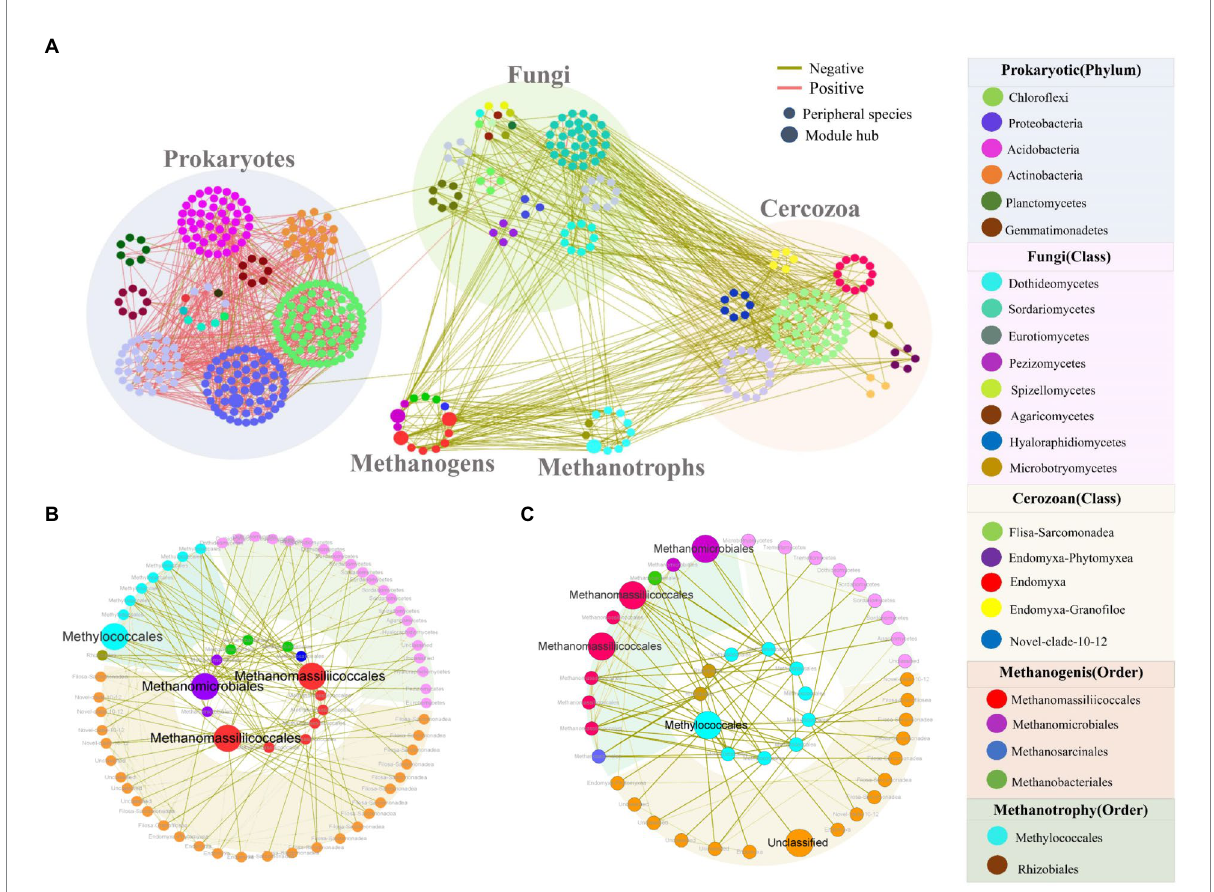
FIGURE 3 Intertrophic networks among five communities and two subnetworks relative to methanotrophic OTUs and methanogenic OTUs. (A) Intertrophic networks of prokaryotic, fungal, cercozoan communities, methanotrophic OTUs and methanogenic OTUs under inundation. Node color indicates different taxonomic. Node size is proportional to network role, with larger nodes being module hubs. Red and green links represent positive and negative interactions, respectively. (B) Subnetworks showing the OTUs related to methanogenic OTUs, inner circle are methanogenic OTUs while outer circles are their connected OTUs. (C) Subnetworks showing the OTUs relative to methanotrophic OTUs, inner circle are methanotrophic OTUs while outer circles are the connected OTUs. The background colors represent different communities: fungi (purple), cercozoa (pink), methanotrophic OTUs and methanogenic OTUs